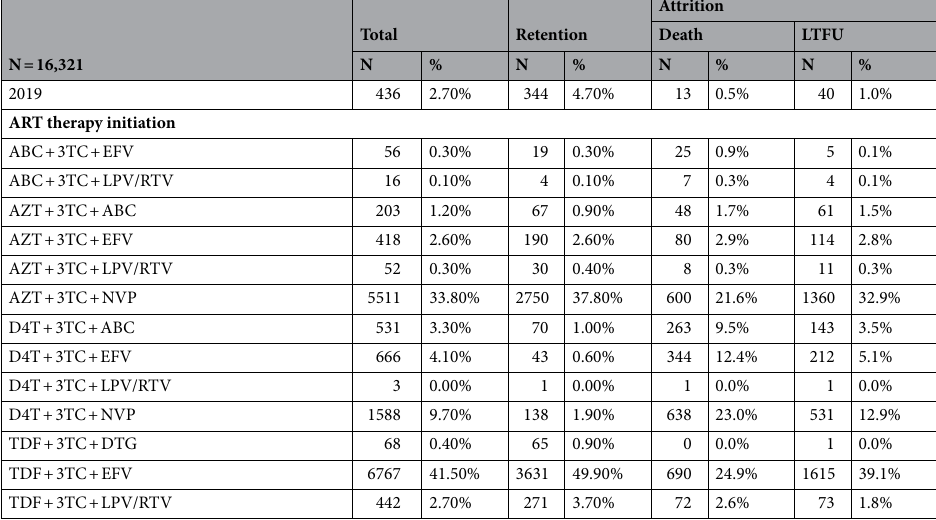
Table 1. Characteristics of HIV patients enrolled at Carmelo Hospital of Chókwè of between January 1, 2002 and December 31, 2019 by Outcome Status. ART antiretroviral treatment, ABC abacavir, 3TC lamivudine,